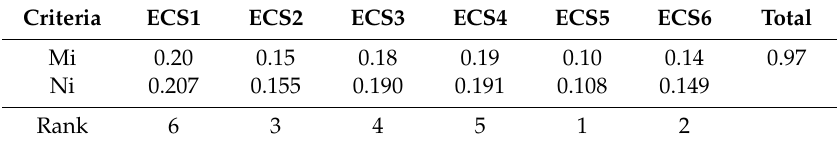
Table 7. The average, normalized weight, and rank of criteria for economic sustainability.